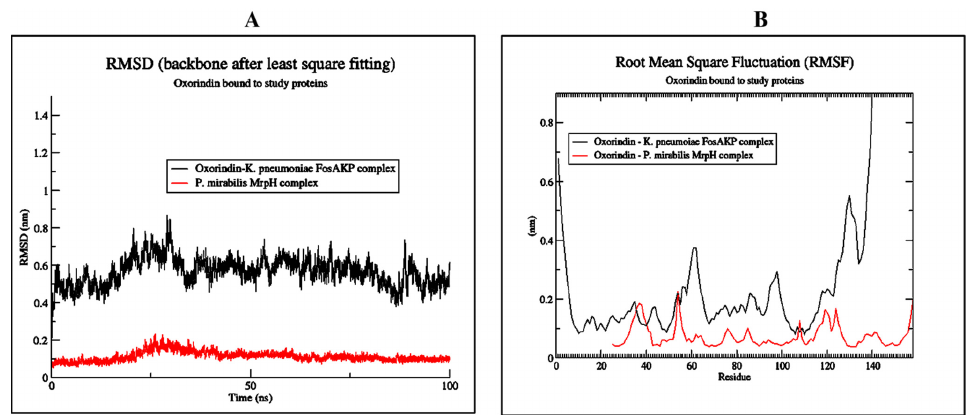
Figure 4. RMSD and RMSF plots of Oroxindin in complex with 5WEW and 6Y4F: ( A ) RMSD, and ( B ) RMSF. The radius of gyration for Oroxindin in complex with 5WEW was 1.7 nm and for 6Y4F it was 1.4 nm, as shown in Figure 5A. The solvent accessible surface area for Orox- indin in complex with 5WEW was 100 nm 2 and with 6Y4F it was 70 nm 2 as shown in Figure 5B. Oroxindin in complex with 5WEW achieved 2 hydrogen bonds up to 35 ns and 5 to 8 hydrogen bonds between 35 ns and 100 ns (Figure 6) whereas 6Y4F achieved 2 to 4 hydrogen bonds throughout the simulation (Figure 6). The radius of gyration, the solvent accessible surface area, and the hydrogen bonding interactions confirmed the stability of Oroxindin in complex with 5WEW and 6Y4F. The binding free energy of the protein lig- and complexes is shown in Figure 7.